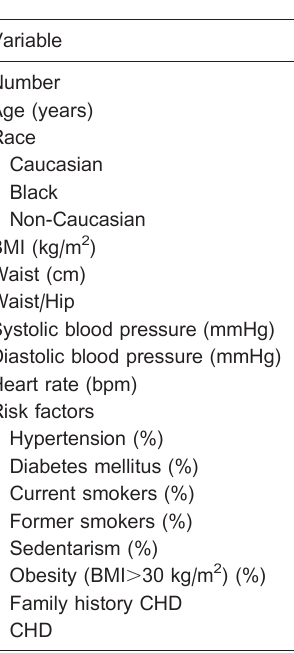
Table 1. Demographic